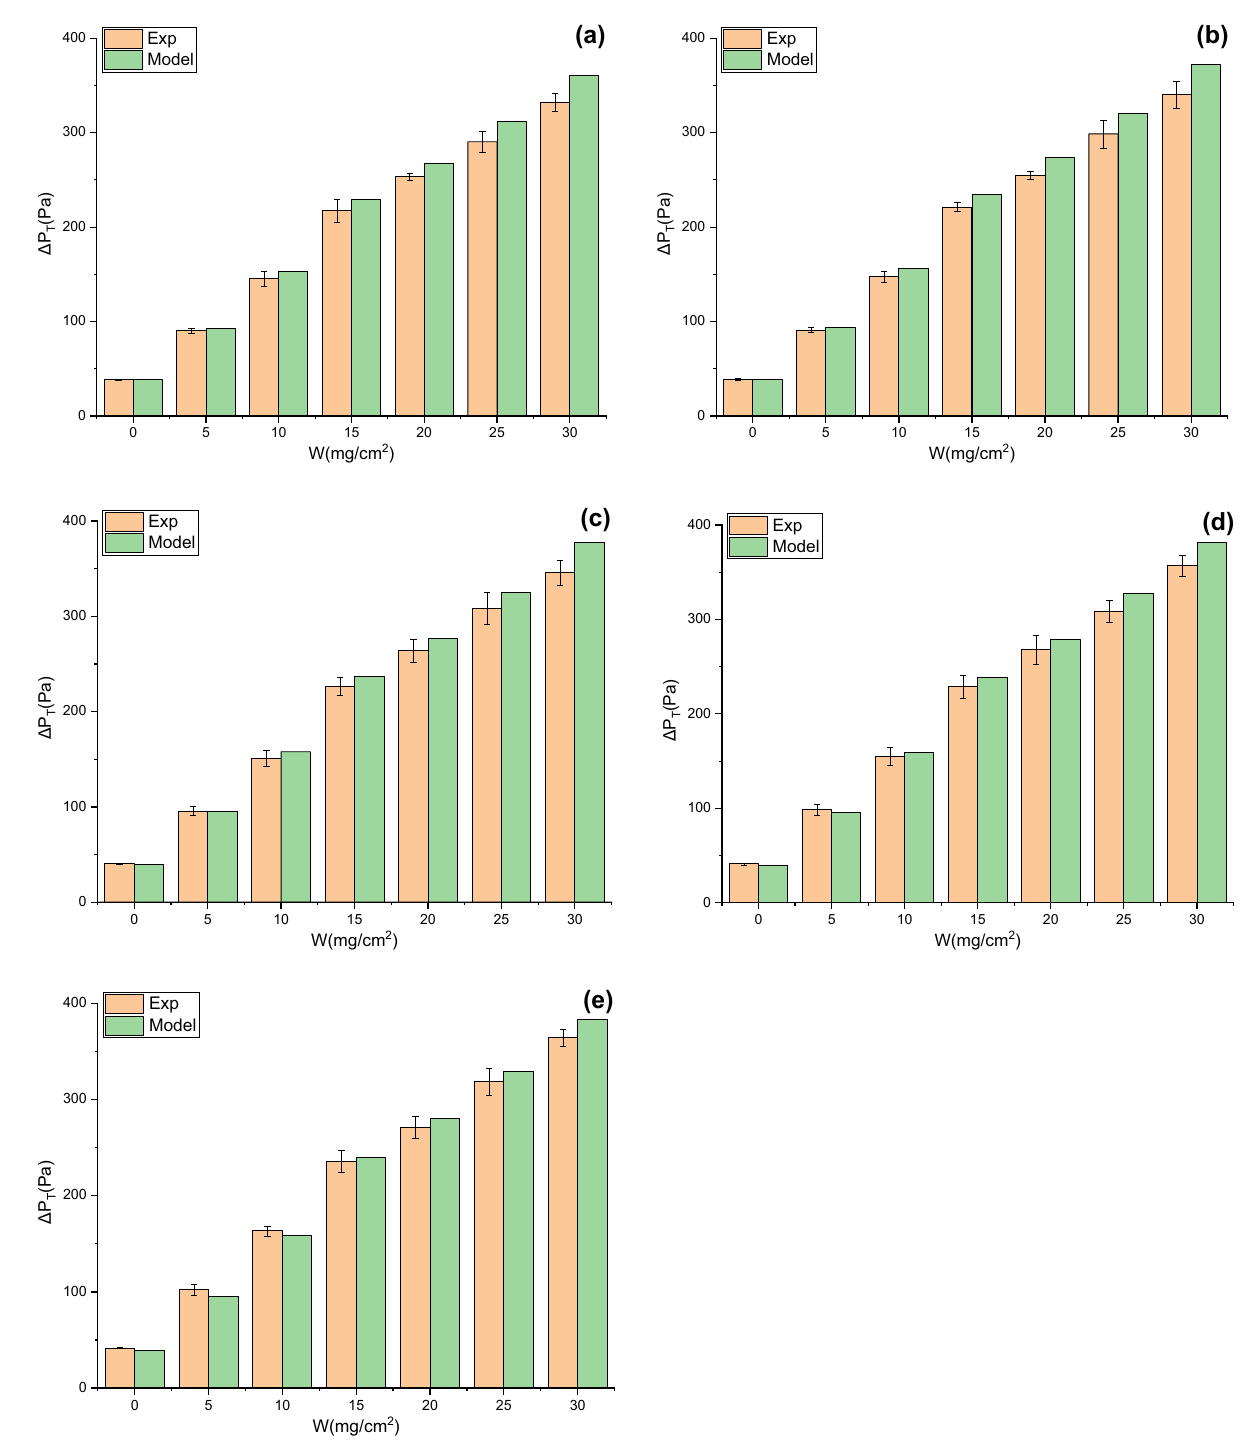
Figure 15. Changes in experimental and modeling total pressure drops with W for U-shaped filter ( a ) α = 0.71, ( b ) α = 1.43, ( c ) α = 2.14, ( d ) α = 2.86, ( e ) α =